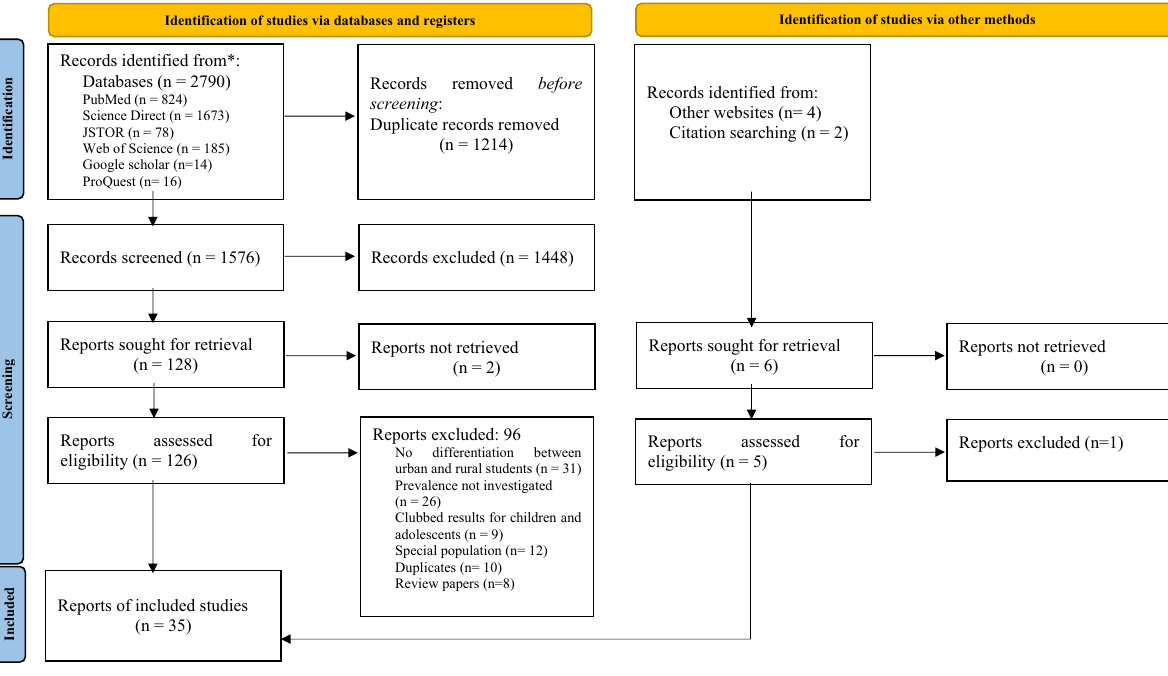
Figure 1. PRISMA flowchart detailing the study selection